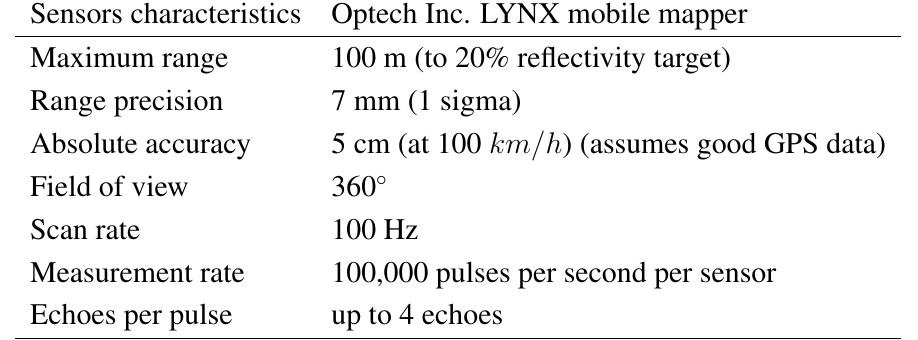
Table 1. Manufacturer specifications of the MLS system used for data